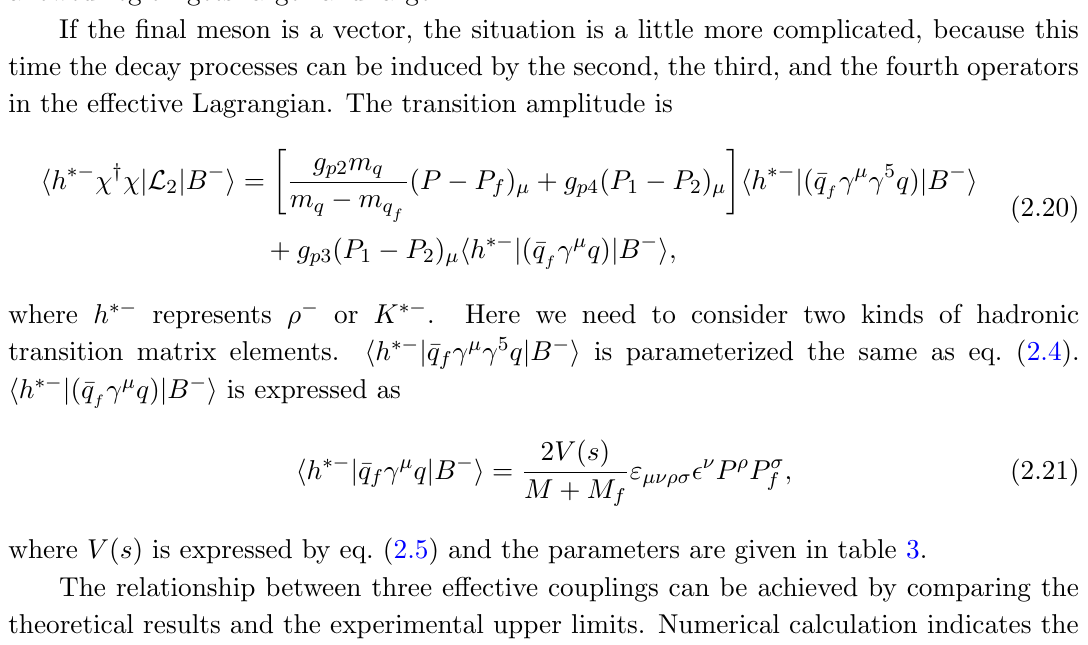
K (cid:0) ( (cid:25) (cid:0) ) (cid:31)(cid:31) y !